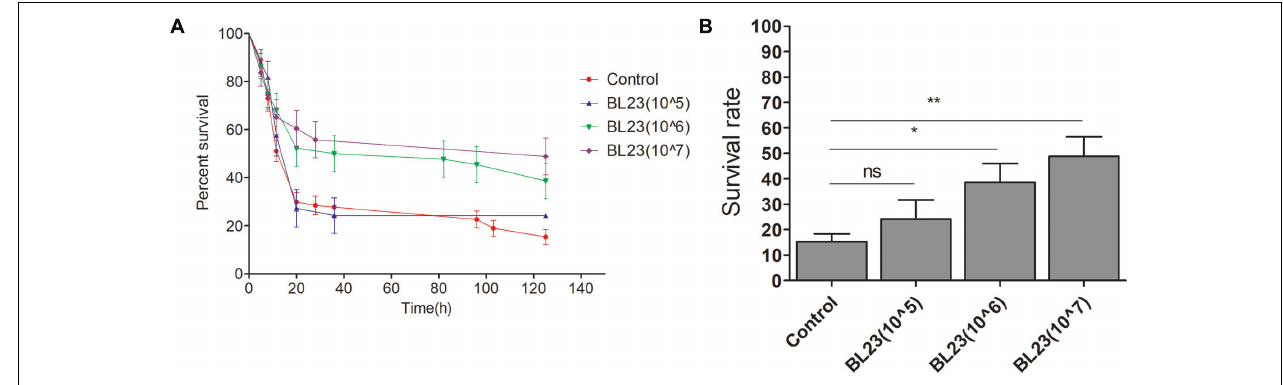
FIGURE 1 | Dose dependent of Lactobacillus casei BL23 protection against Aeromonas veronii infection in conventional zebrafish larvae. The survival rate (A) and final survival rate (B) of zebrafish larvae treated with L. casei BL23 at a dose of 10 5 , 10 6 , and 10 7 CFU/ml, respectively, after infected with A. veronii . Asterisks indicate significant difference compared with control ( ∗ P < 0.05, ∗∗ P < 0.01, ∗∗∗ P < 0.001).